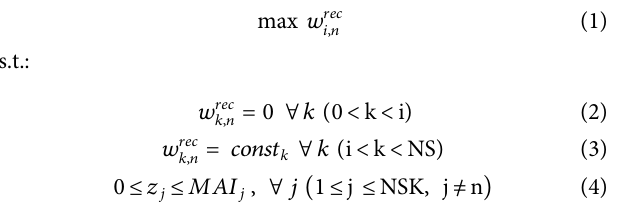
Frontiers in Chemical Engineering |